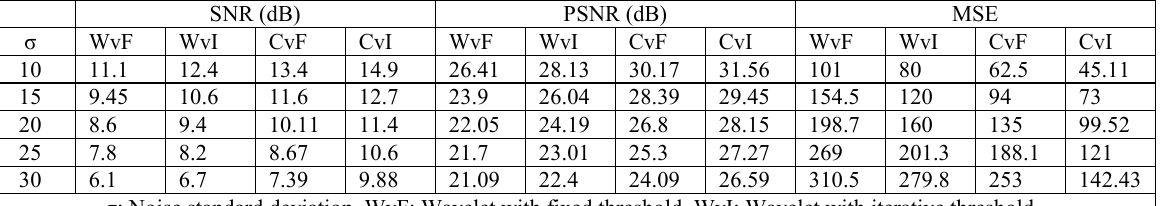
Table 2: Performance of Noise Filtering for Landsat TM